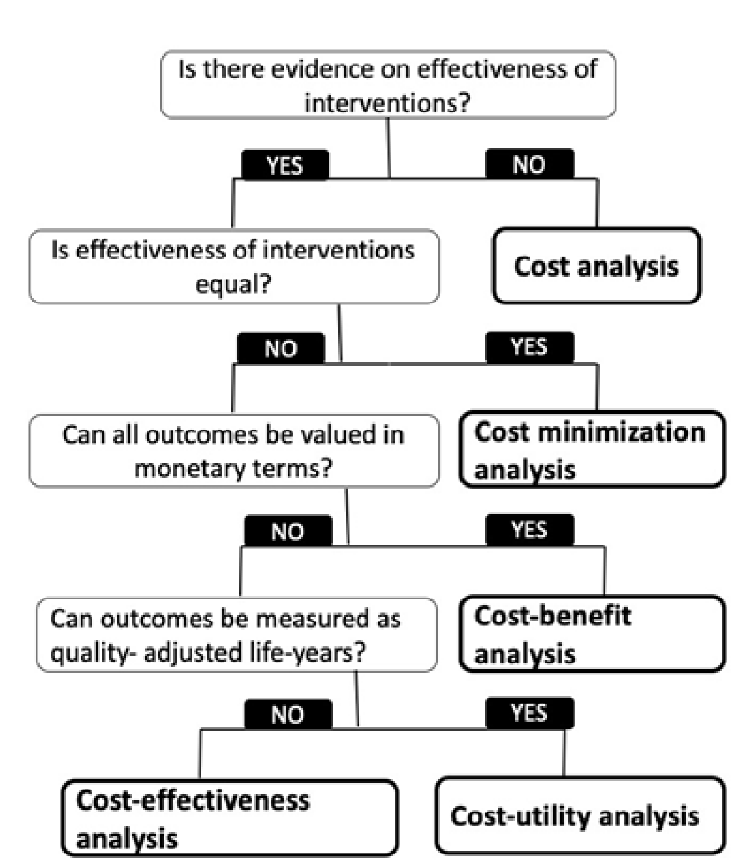
Figure 1. Algorithm to identify the type of economic evaluation based on their characteristics